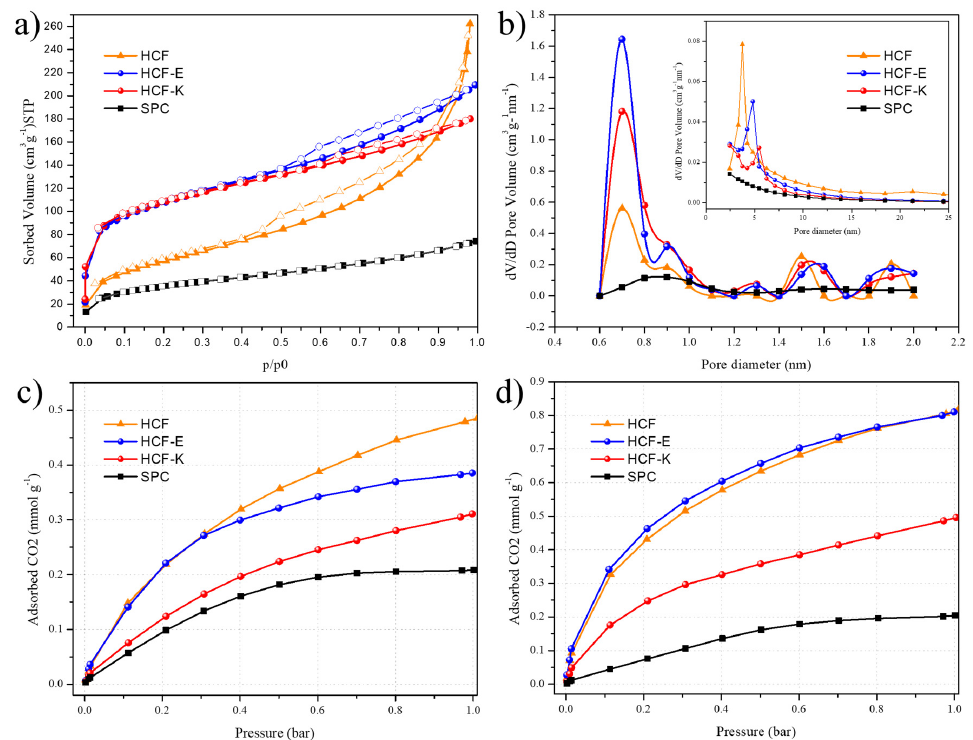
Figure 4. Textural properties of HCFs and CO 2 adsorption. ( a ) N 2 adsorption–desorption isotherms at liquid nitrogen temperature (77 K). ( b ) Pore size distribution extracted from t-plot for microporosity and BJH desorption for mesoporous pore distribution (inset). ( c ) CO 2 adsorption isotherms at 298 K. ( d ) and 273